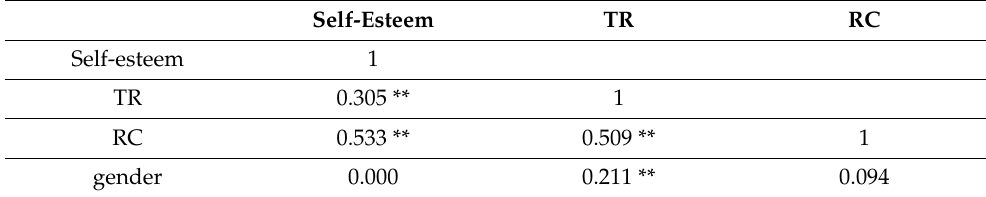
Table 3. Correlation between variables by sex (N = 302, male = 115, female = 187). Self-Esteem TR RC Self-esteem 1 Male TR 0.392 ** 1 RC 0.667 ** 0.477 ** 1 Self-esteem 1 Female TR 0.250 ** 1 RC 0.432 ** 0.525 **